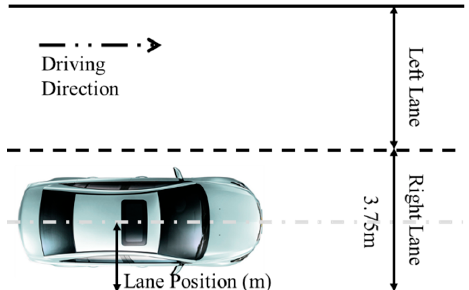
Figure 3. Description of vehicle lane position. Note: Lane position was defined according to the distance between the center of the vehicle and the edge line (0.2-m width) of the right lane: 1.9–2.2 m = driving in the middle of the right lane; 2.8 m and over = deviation from lane to the left lane; 1.3 m and under = deviation from lane to the right shoulder.